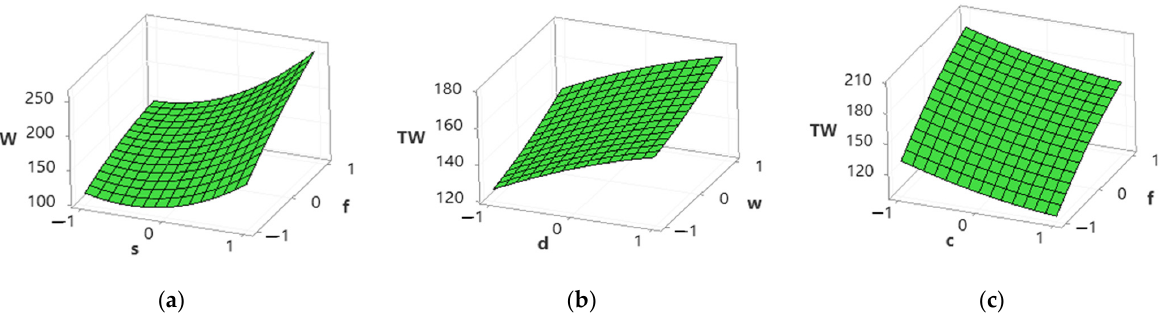
Figure 9. Surface plots for tool wear. ( a ) Spindle speed vs. feed rate; ( b ) depth of cut vs. width of cut; ( c ) cutting conditions vs. feed rate.